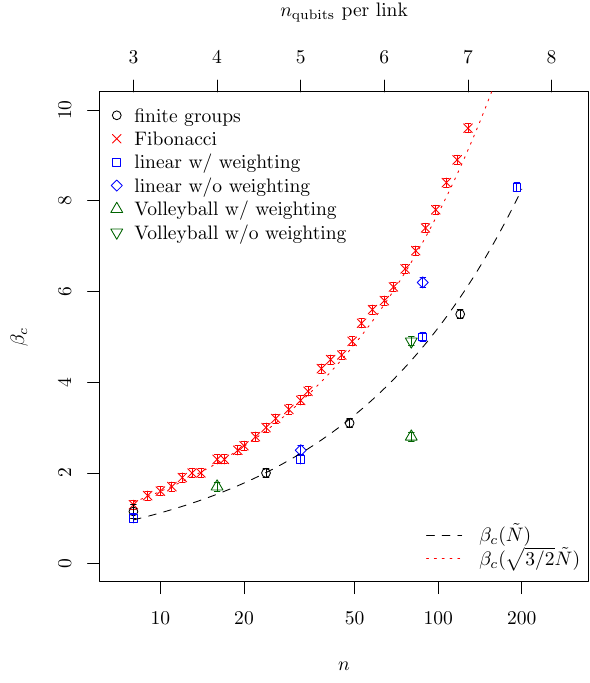
Fig. 5 The critical value β c as a function of the number n of elements in the set. The lines represent the approximation Eq. (30) where the order ˜ N ( n ) is obtained from Eq.